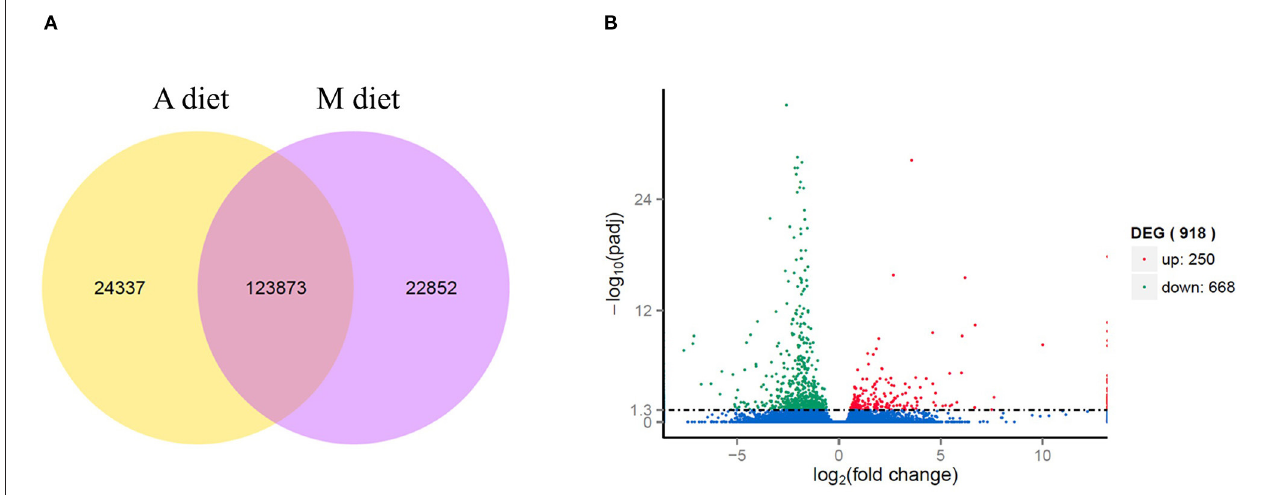
FIGURE 1 | A Venn diagram showing the number of co-expressed genes and uniquely expressed genes between M and A diets (A) . Overall distribution of differentially expressed genes (DEGs) represented by a volcano plot (B) . The normalized gene expression values and the corresponding normalized p -value are presented by dots. The statistically significant upregulated genes are represented by red dots, down-regulated genes are represented by green dots, and blue dots show no difference in expression.